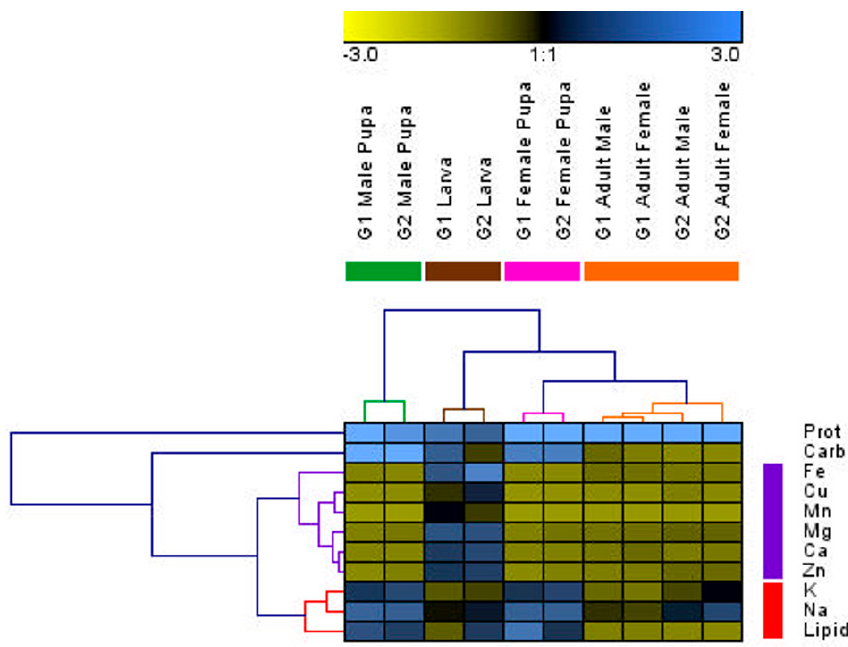
Figure 3. Mean percent change of nutrients relative to initial nutrients (PCN). Increases in PCN are indicated by levels of blue and decreases in PCN are indicated by yellow. Results for the hierarchal analysis are shown for the nutrients and the life stages.